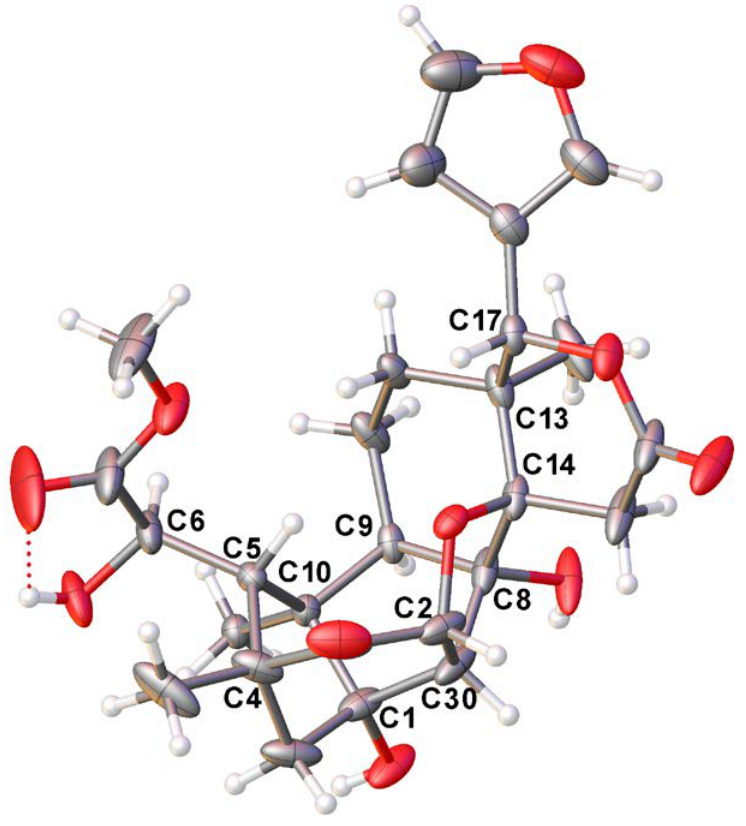
Figure 3. X-ray structure of compound 2 ; only the asymmetric carbon atoms are labeled.